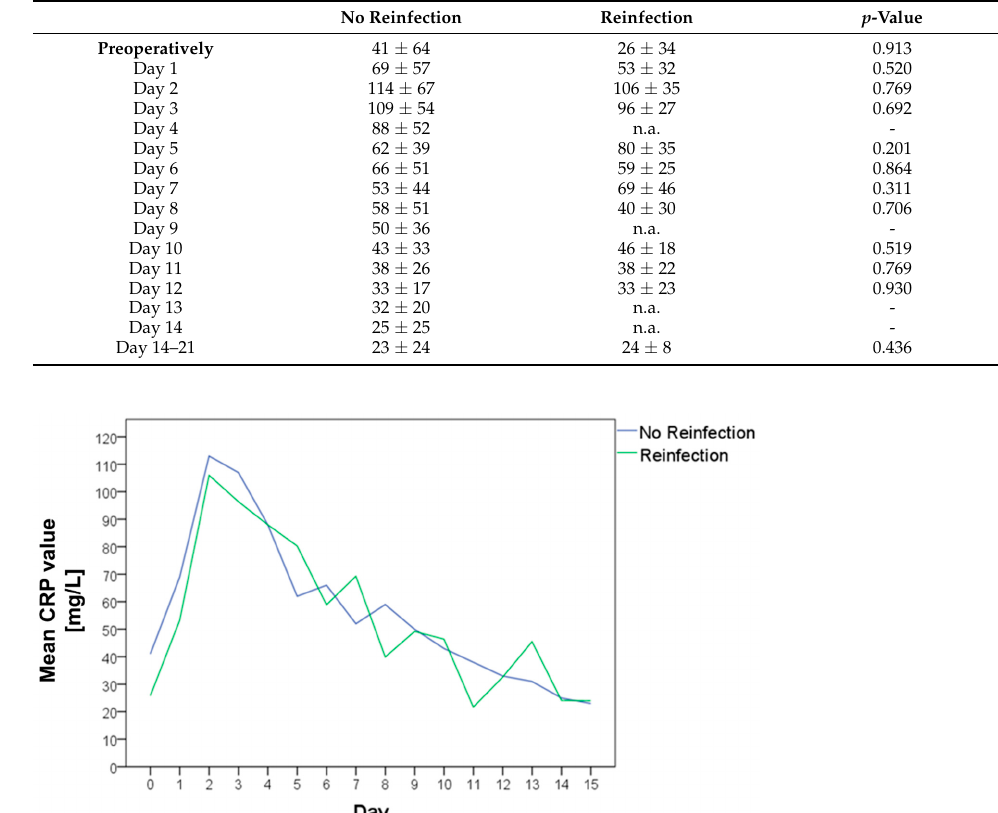
Table 3. Mean CRP values (in mg/L) preoperatively and at different points of follow-up.